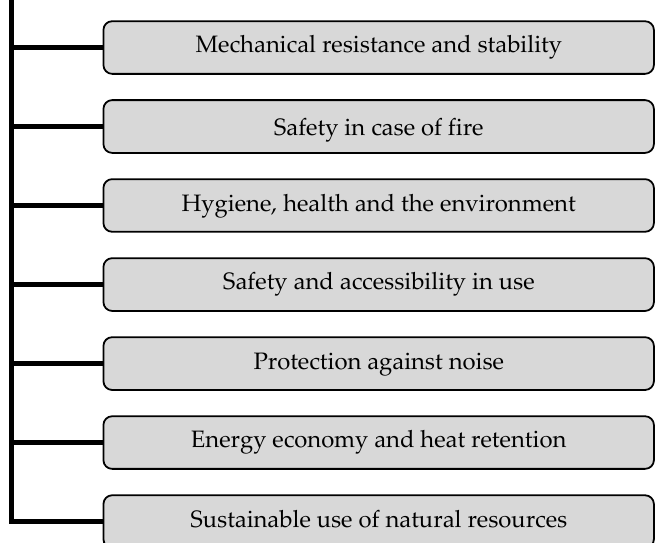
Figure 2. The scope of the requirements for construction objects (Regulation 2011).